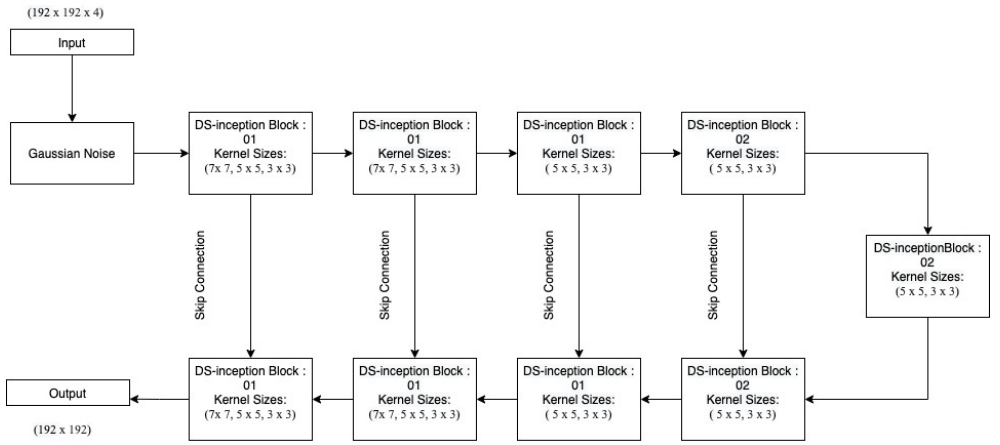
Figure 10. Second Architecture: Depthwise separable recurrent-inception Network.